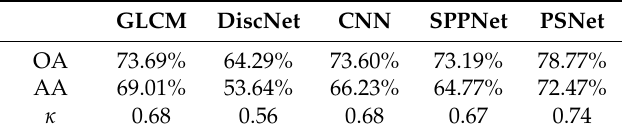
Figure 18. Classification map overlaid with ground truth for the Orchard data (using 30% of data for training). Three regions are selected in ( a ) for the convenience of comparison. The unidentifiable class is shown in white. Table 8. Classification performance comparison on Orchard data using overall accuracy (OA), average accuracy (AA) and Kappa coefficient ( κ